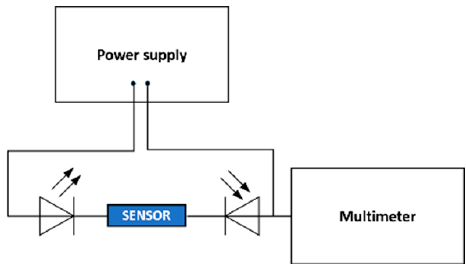
Figure 2. Schematic representation of the experimental setup used for the evaluation of the transmission losses due to the manufacturing procedures.